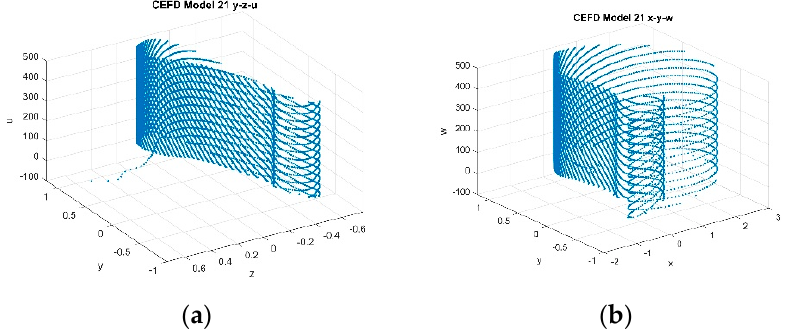
Figure 25. Phase portraits ( a ) y − z − u , ( b ) x − y − w , at h = 0.002, k = 2, p = 1, α 5 = 0.24 for model (21) CEFD.